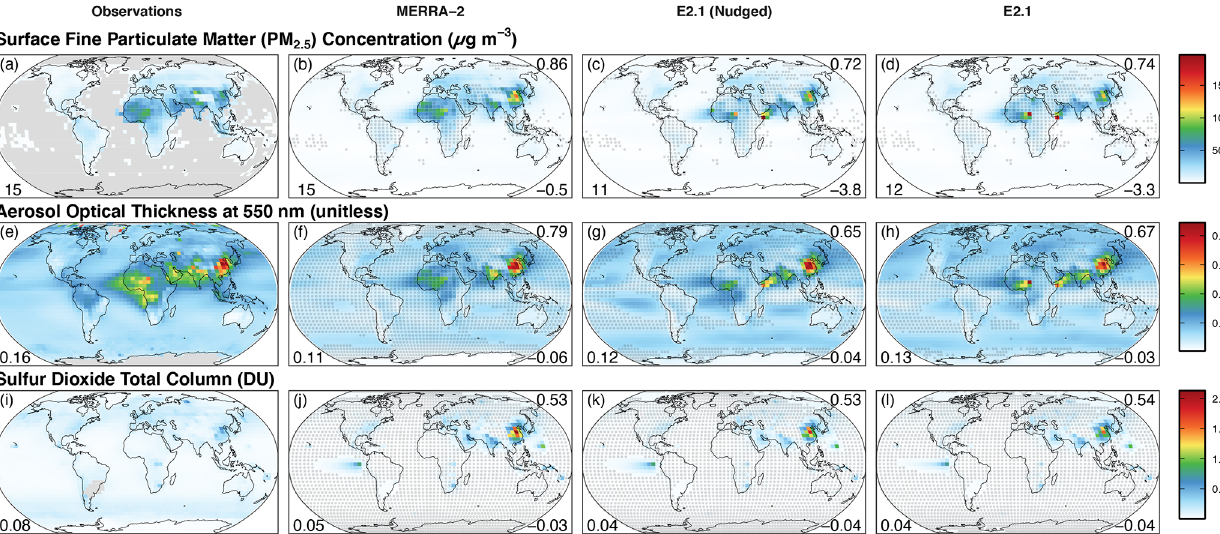
Figure 18. Annual average surface concentration of fine particulate matter (PM 2 . 5 ; in µgm − 3 ; top row), aerosol optical thickness at 550nm (unitless; middle row), and total column of sulfur dioxide (in Dobson units; bottom row) for 2005–2014CE. The left column from top to bottom shows observations from Hammer et al. (2020), Aqua MODIS, and OMI (Li et al., 2020a), respectively. The three columns on the right show equivalent values determined from GEOS-Chem driven by MERRA-2, E2.1 nudged to MERRA-2, and free-running E2.1 meteorology. Gray dots show locations where the simulated values are statistically different from the observations with respect to interannual variability ( p value < 0.05; n = 10 years). The number in the lower left of each panel shows the global mean value. The number in each model panel’s top right shows the pattern correlation ( R ) between the simulated and observed values. The number in the lower right shows the mean bias of the model with respect to the